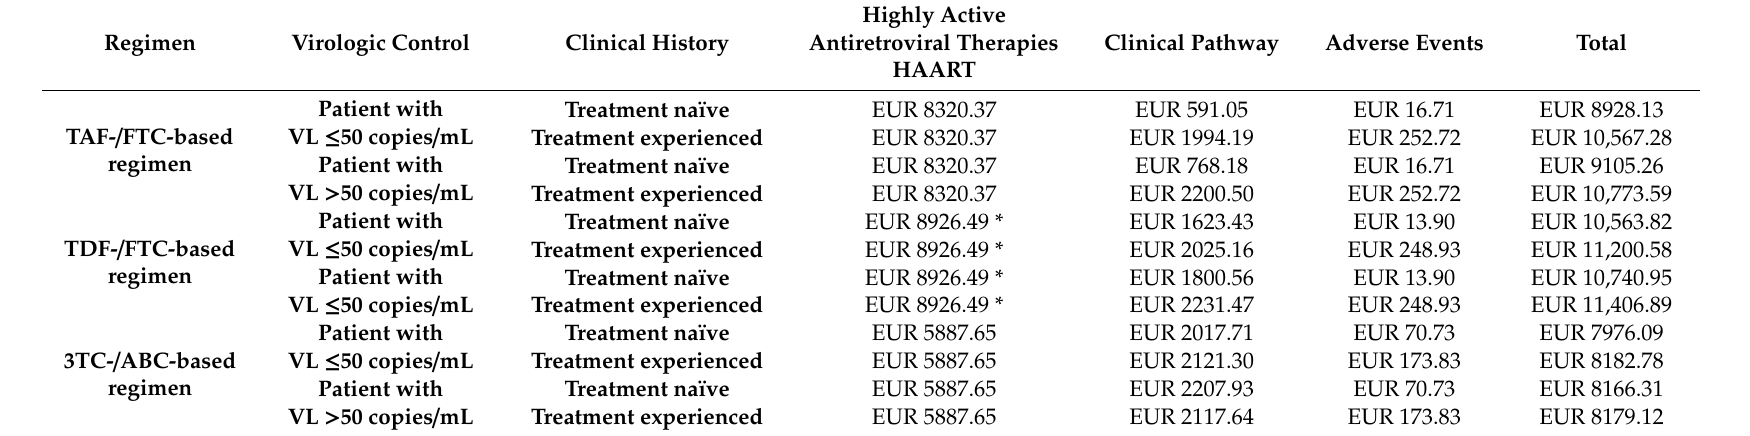
Table 5. The total cost of HIV + patient management, stratified for patients’ characteristics. Source: data gathered by